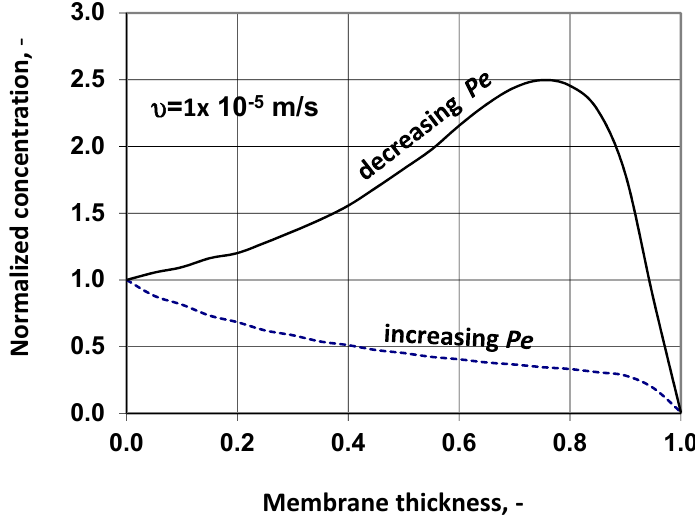
Figure 4. Concentration distribution across the membrane layer with a varying convective velocity and with a constant diffusion coefficient ( D = 1 × 10 − 9 m 2 /s; δ = 5 × 10 − 4 m; k o = 0.2 × 10 − 5 m/s; υ = 1 × 10 − 5 m / s; N = 50) Values of the convective velocity were changed with its linear function with the space coordinate: Pe -number changed between 0.2 and 0.5 with an increasing, i.e., υ i = υ (0.2 + 0.8 i / N ), and 0.5 and 0.2 with a decreasing Pe -number with υ i = υ (1 − 0.8 i / N ).